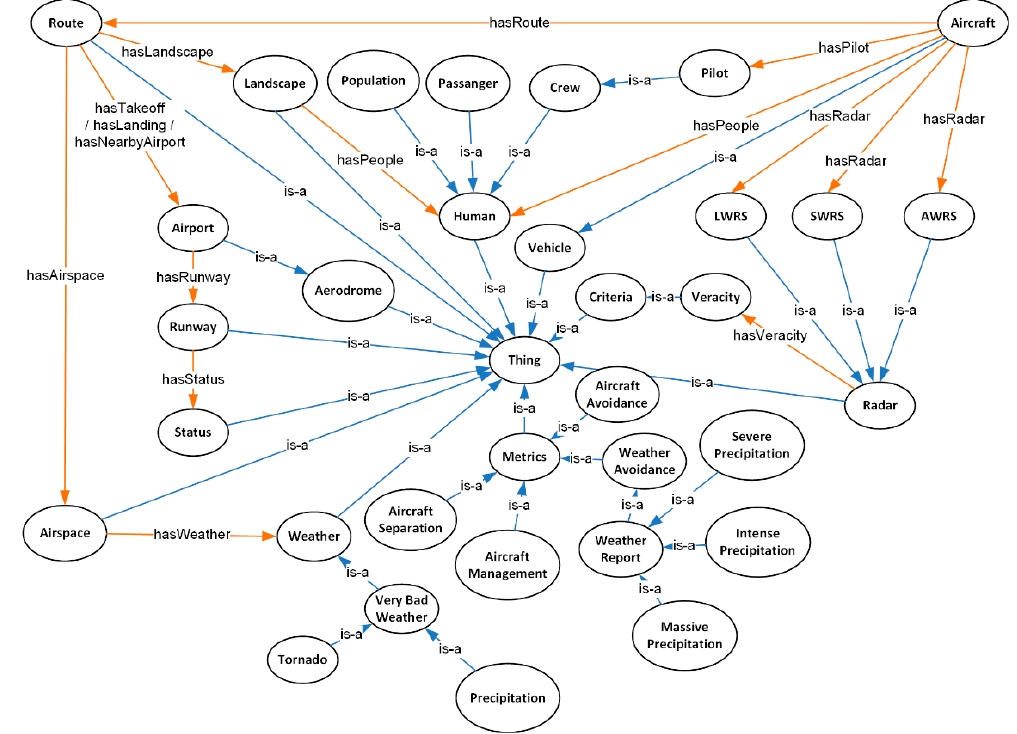
Figure 4. Avionics Analytics Ontology (AAO) Classes.